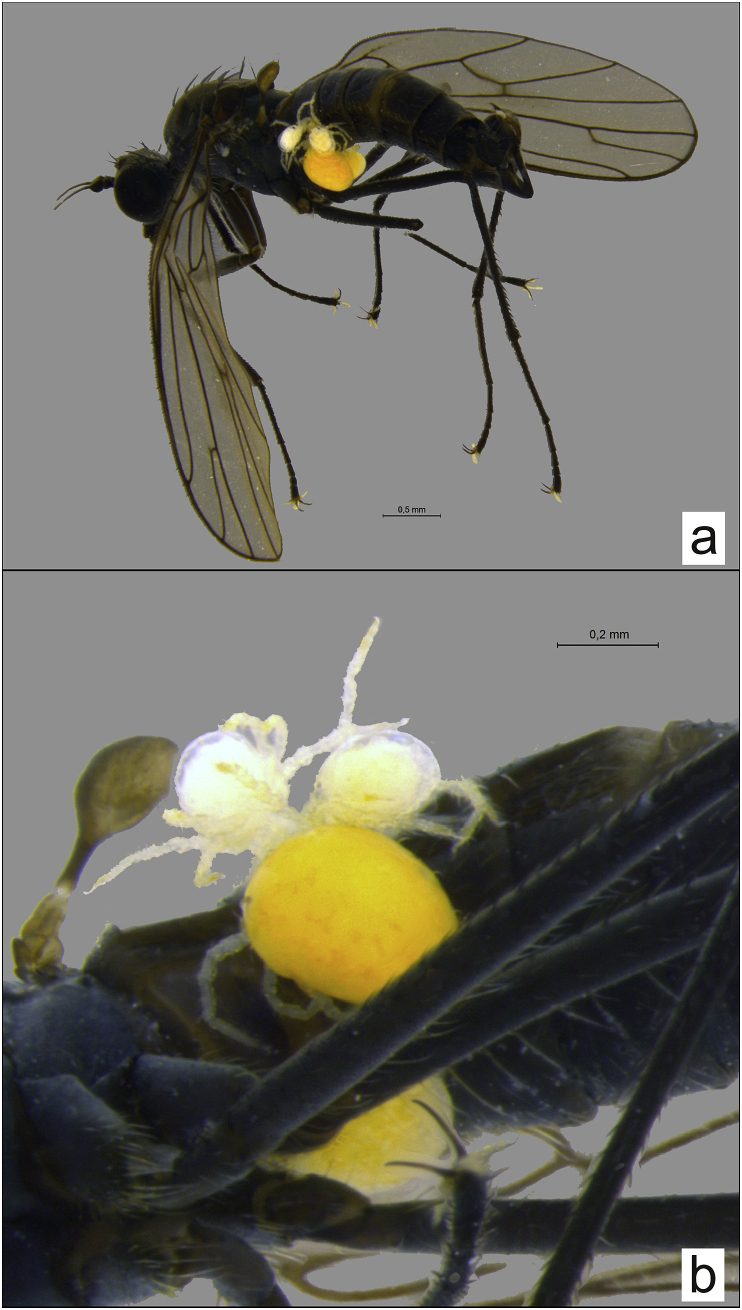
Clinocera storchi parasitized by Panisopsis curvifrons; a – habitus, b – abdomen.